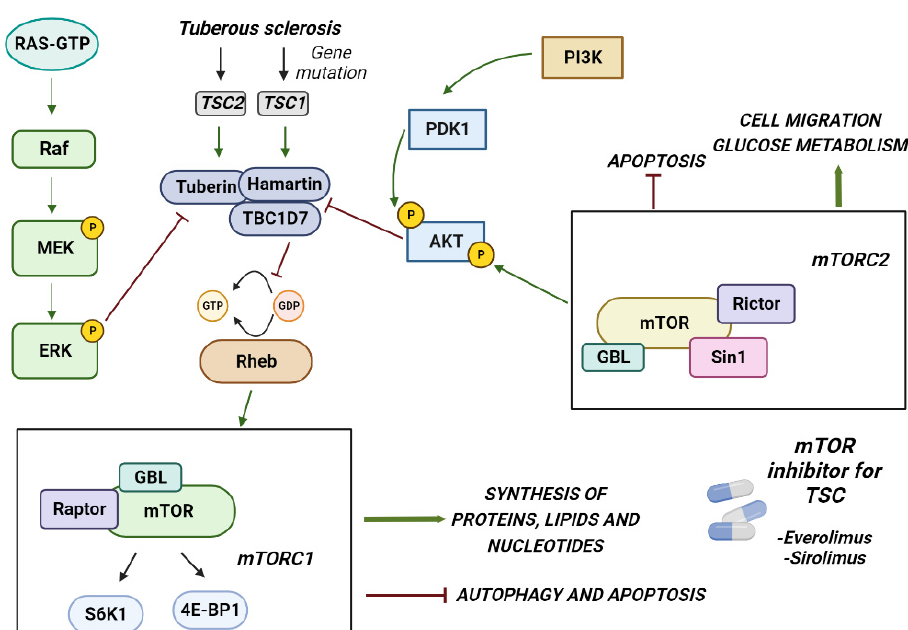
Figure 1. The figure shows how the mTORC1 pathway is involved in the development of TSC. The figure shows the genes involved in the development of TSC and the pathway activated by different proteins. In particular, mTORC1 may contribute to the symptoms of TSC when hyperactivated by the malfunction of the TBC1D7 tuberin and hamartin complex. Two of the FDA-approved kinase inhibitors for the treatment of TSC are also shown in the